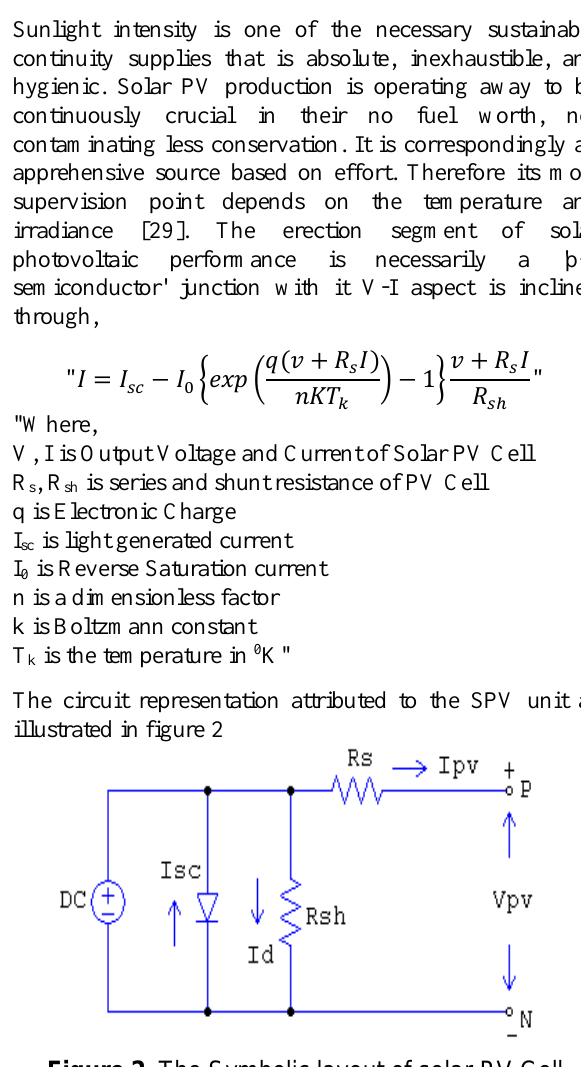
Figure 2. The Symbolic layout of solar PV Cell EAI Endorsed Transactions on Energy Web 12 2022 - 12 2022 | Volume 9 | Issue 5 |